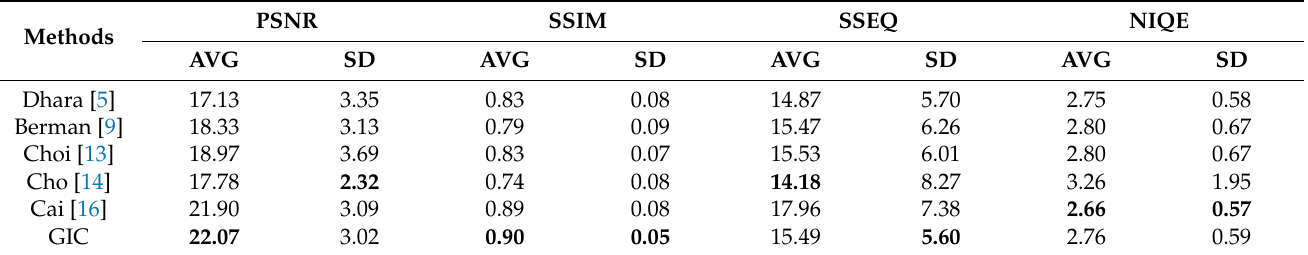
Table 2. Comparison of evaluation indexes in image dehazing.